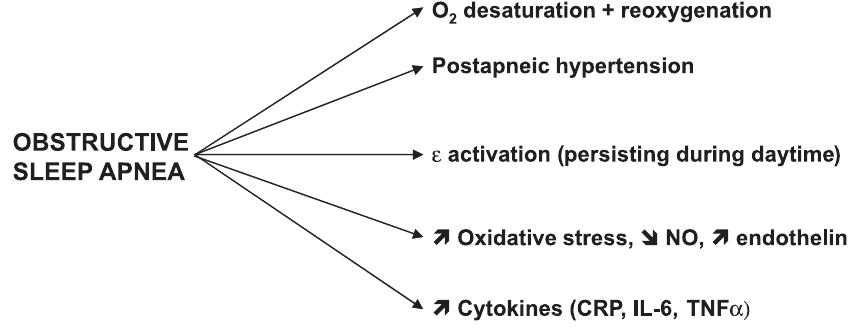
Figure 2 - Main cardiometabolic consequences of obstructive sleep